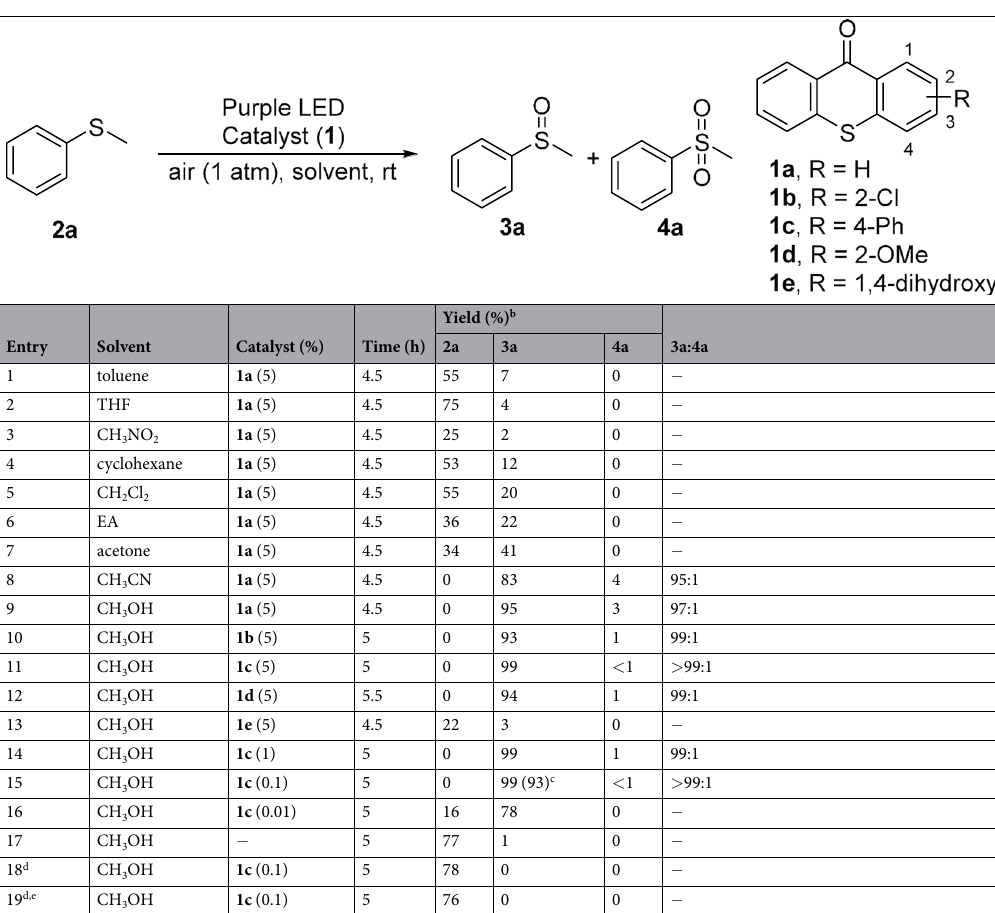
Table 1. Optimization of the reaction conditions a . a All reactions were carried out using 2a (1 mmol) and catalyst in solvent (5 mL) irradiated by a purple LED light at rt under air atmosphere b . The yield was determined by 1 H NMR (400 MHz) analysis of the crude reaction mixture employing CH 2 Br 2 (1 mmol) as the internal standard c . Isolated yield of 3a d . The reaction was carried out without light e . The reaction was carried out at 50